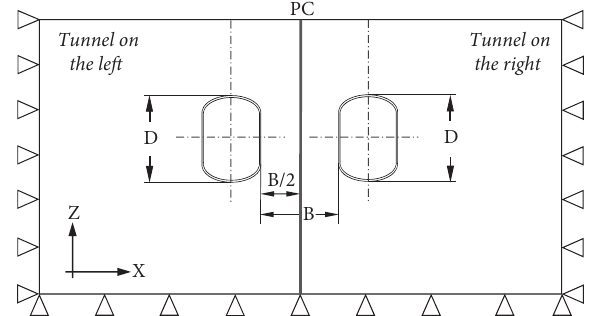
Figure 5: Typical cross-section view of twin tunnels with axis of symmetry PC located between two tunnels (not to scale). Note . D � maximum diameter of horseshoe section